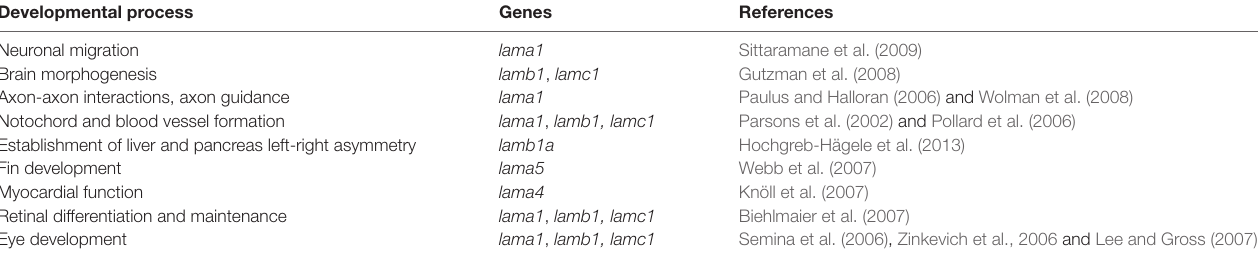
TABLE 1 | Examples of developmental processes where laminins are involved.